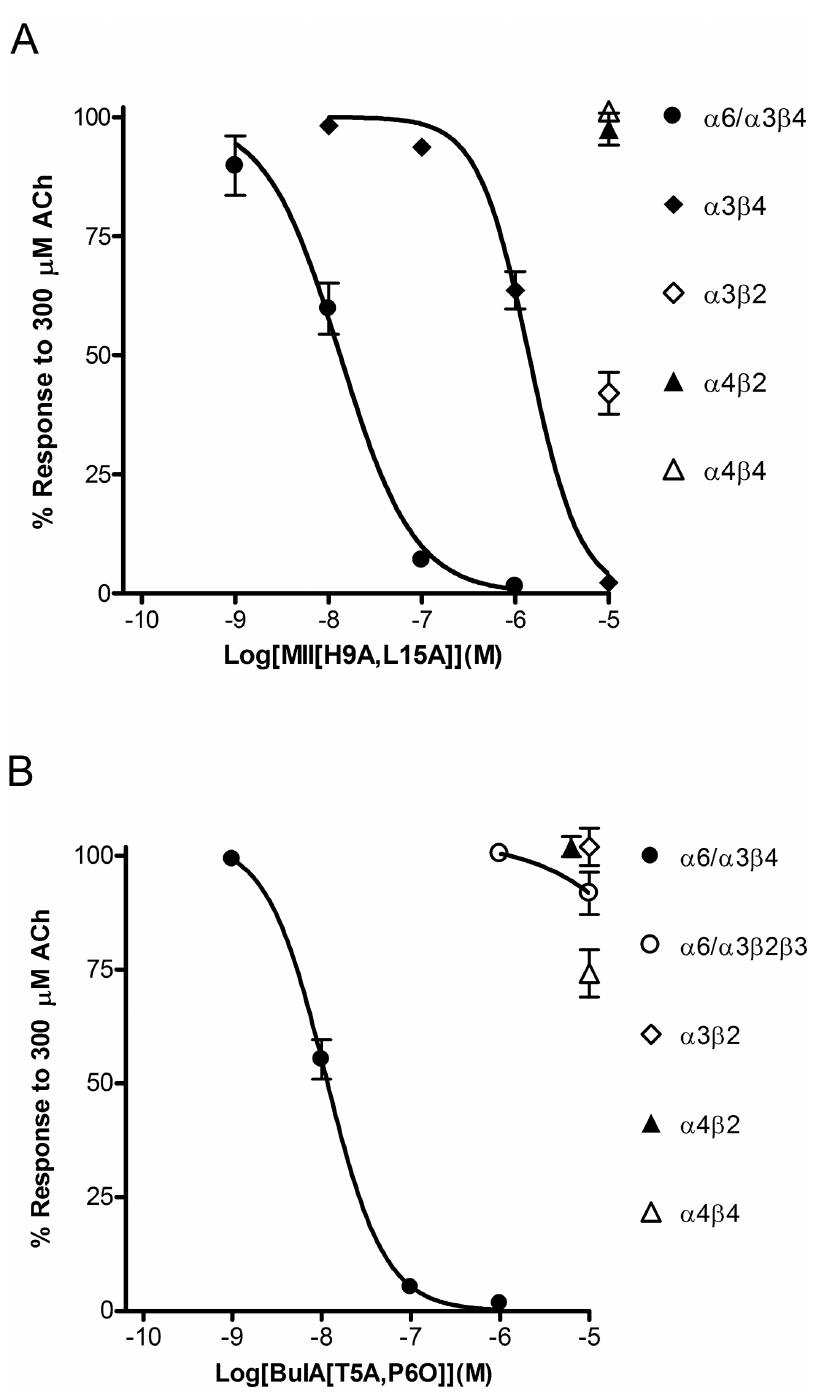
Figure 4. Concentration-response analysis of the inhibition of cloned human nAChRs expressed in X.laevis oocytes by a -Ctxs MII[H9A,L15A] and BuIA[T5A,P6O]. Oocytes expressing the indicated nAChRs were subjected to TEVC as described in ‘‘Materials and Methods’’ and the IC 50 values for inhibition of the responses to ACh by each a -Ctx analog determined by fitting the data to the Hill equation. A, MII[H9A,L15A] inhibited a 6/ a 3 b 4 with an IC 50 value of 13.3 (9.7–18.1) nM (n=4) and a 3 b 4 with an IC 50 value of 1.4 (1.1–1.7) m M (n=4). Compared to controls, the responses after a 5 min exposure to 10 m M toxin were 42 6 4% (n=7) for a 3 b 2, 93 6 5% (n=7) for a 4 b 2, and 101 6 1% (n=4) for a 4 b 4 receptors. B, BuIA[T5A,P6O] inhibited a 6/ a 3 b 4 with an IC 50 value of 11.1 (9.1–13.6) nM and a 6/ a 3 b 2 b 3 with an IC 50 value . 10 m M. The responses after a 5 min exposure to 10 m M toxin were 102 6 4% (n=4) for a 3 b 2, 102 6 2% (n=4) for a 4 b 2, and 74 6 5% (n=5) for a 4 b 4 receptors. For clarity, the symbols for inhibition of a 3 b 2 and a 4 b 2 receptors are shown staggered to avoid overlap.